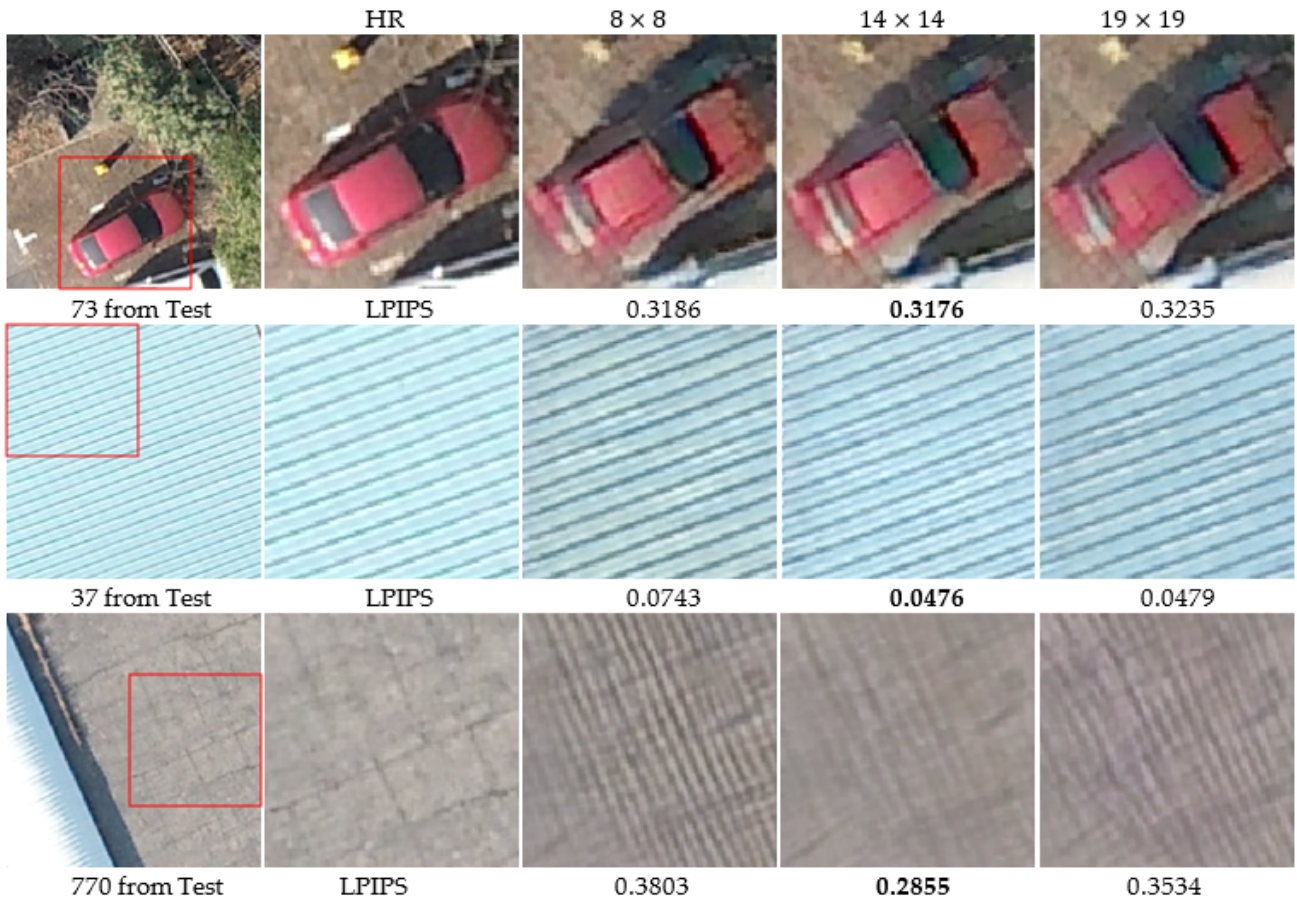
Figure A3. Experimental results of models using different discriminative matrix sizes. The best performance in bold.